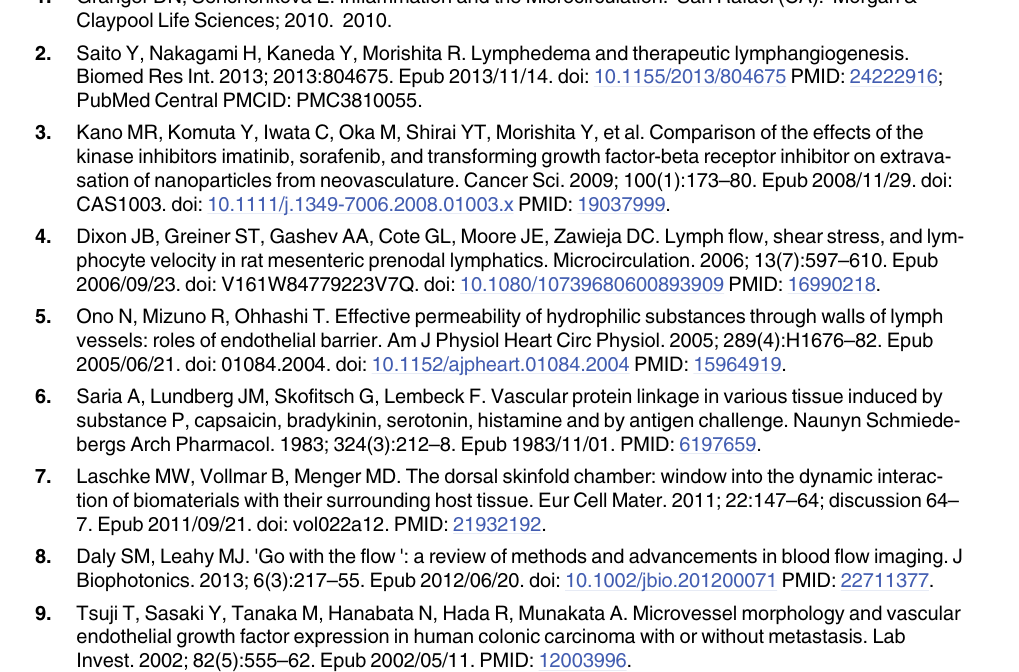
S1 Fig. Microfluidic conditions used for cell culture. S2 Fig. Typical fluorescence micrographs obtained in permeation tests. The bifurcation of the microchannels is shown. Red: upper channel. Green: lower channel. S3 Fig. Time course of Ca 2+ responses to histamine stimulation observed in (a) BECs and (b) LECs cultured in the microdevice (single-channel device without the permeable mem- brane) or the 5-mm-diameter well for monoculture. S4 Fig. Immunofluorescence staining for VE-cadherin and claudin-5 after histamine stim- ulation (the 5-mm-diameter well for monoculture). S5 Fig. Typical cell morphology at 20 min after the addition of 1000-fold-diluted habu snake venom. The arrow indicates a gap in the cell